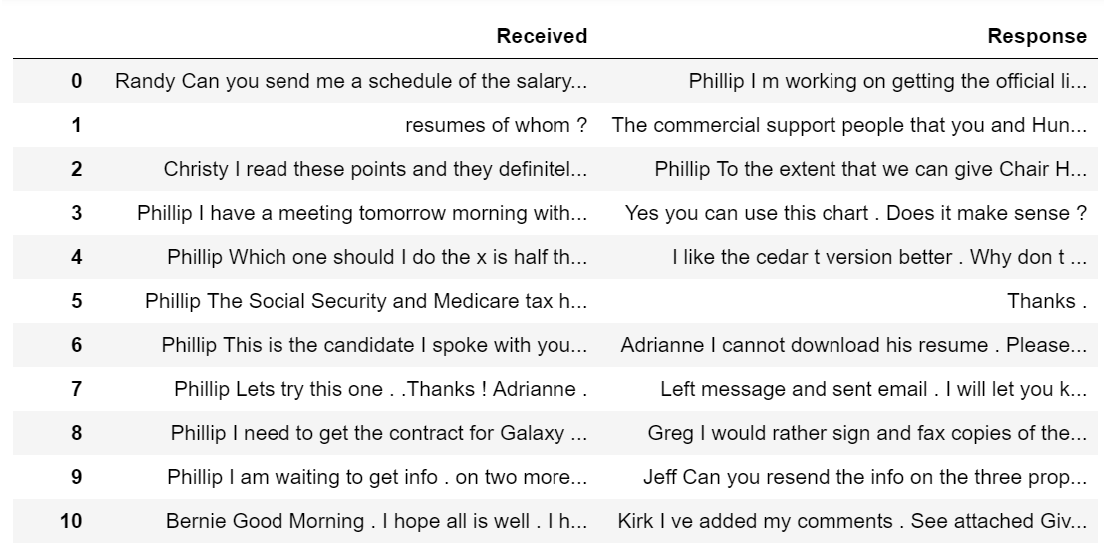
Figure 7. Received-Response E-mail